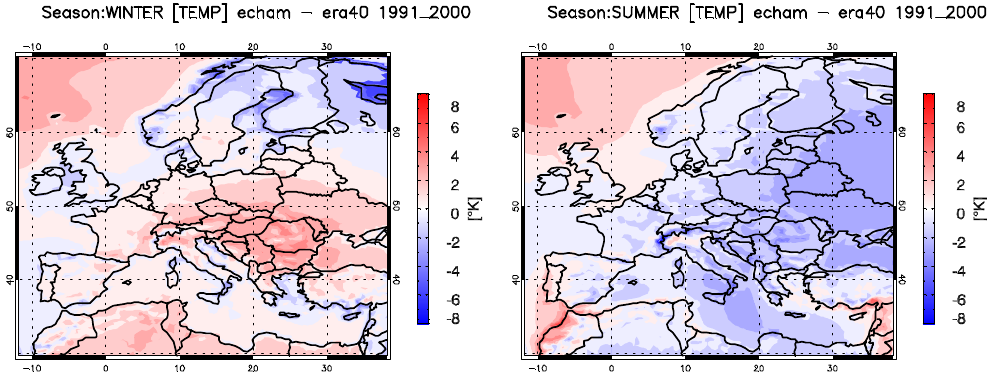
Fig. 4. Differences in simulated average surface temperature fields between the ECHAM and ERA simulations for winter (left) and summer (right) representative of the 90s.